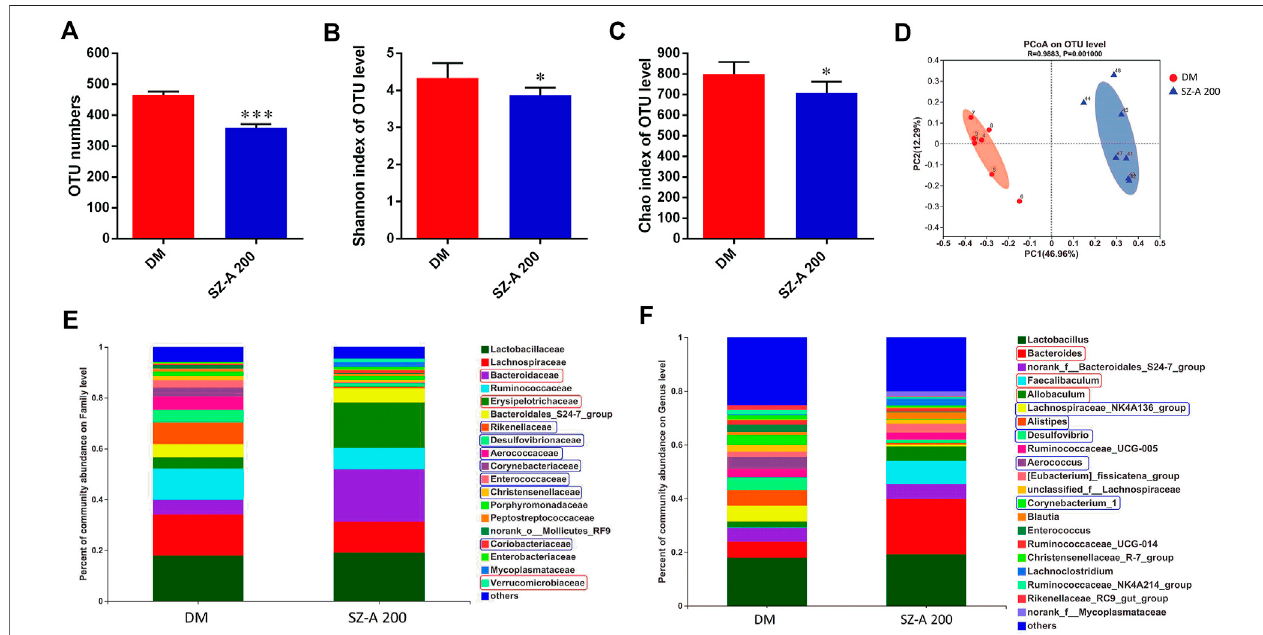
FIGURE 2 | SZ-A modulates the composition of gut microbiota of KKAy mice. (A) Total OTU numbers. (B) Shannon index. (C) Chao index. (D) PCoA. (E) Percentage of community abundance of microbiota at the family level. (F) Percentage of community abundance of microbiota at the genus level (upregulated, red box; downregulated, Blue box) data are shown as mean ± SEM, n (cid:1) 7. * p < 0.05, *** p < 0.001 vs . DM. DM, diabetic model group, SZ-A 100, SZ-A low-dose-treated group, SZ-A 200, SZ-A-high-dose-treated